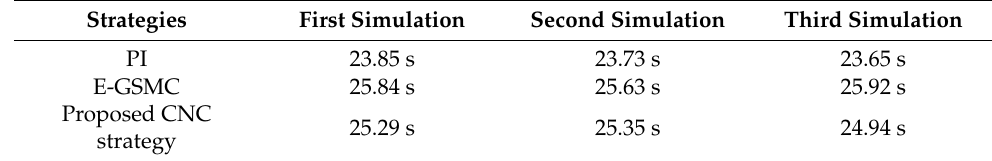
Table 2. The time costs of three strategies.